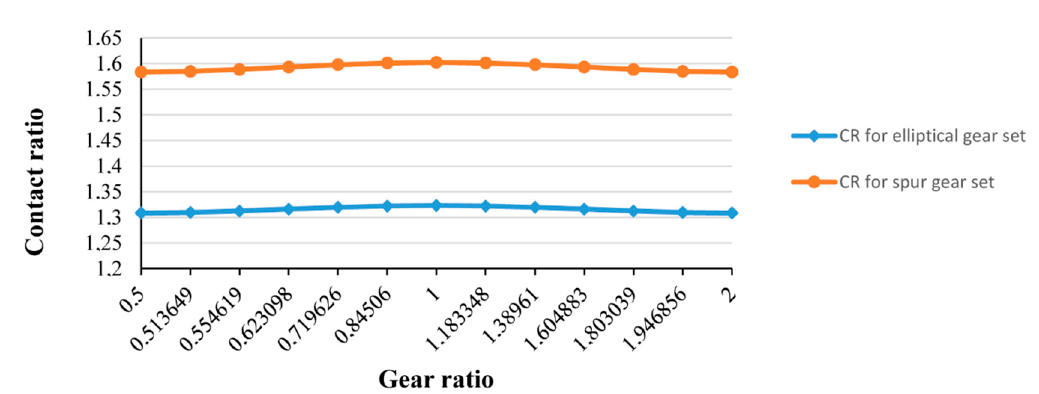
Figure 24. The course of contact ratio for elliptical and spur gear sets.